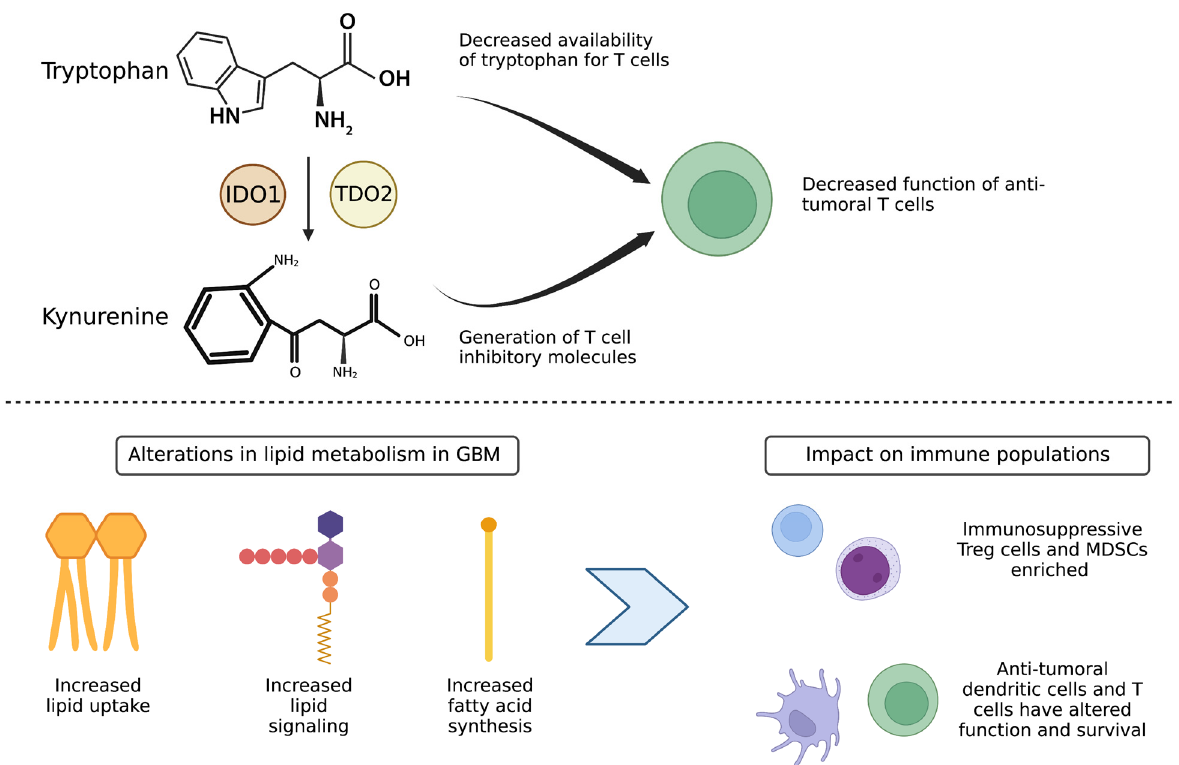
Figure 2. Altered tryptophan metabolism and lipid metabolism in GBM tumor cells contributes to an immunosuppressive population enriched tumor microenvironment. ( Top ) Tryptophan metabolism and generation of kynurenine degradation products by the enzymes IDO1 and TDO2 leads to decreased availability of tryptophan for T cells and generation of T cell inhibitory molecules, leading to decreased function of anti-tumoral T cells. ( Bottom ) Alterations in lipid metabolism lead to increased fatty acid oxidation and lipid signaling by immunosuppressive Treg and MDSC cells, leading to their enrichment over anti-tumor dendritic cells and cytotoxic T cells.